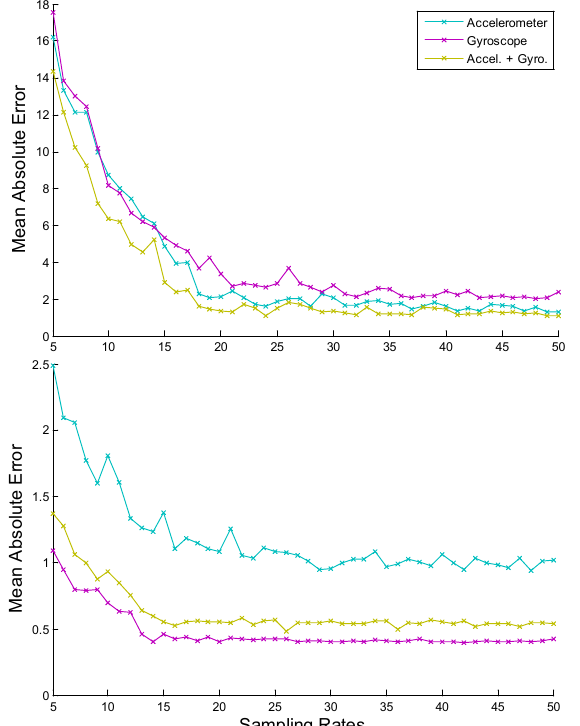
Fig. 6. Mean absolute error for heart rate (top) and breathing rate estimation (bottom) when considering different sampling rates.